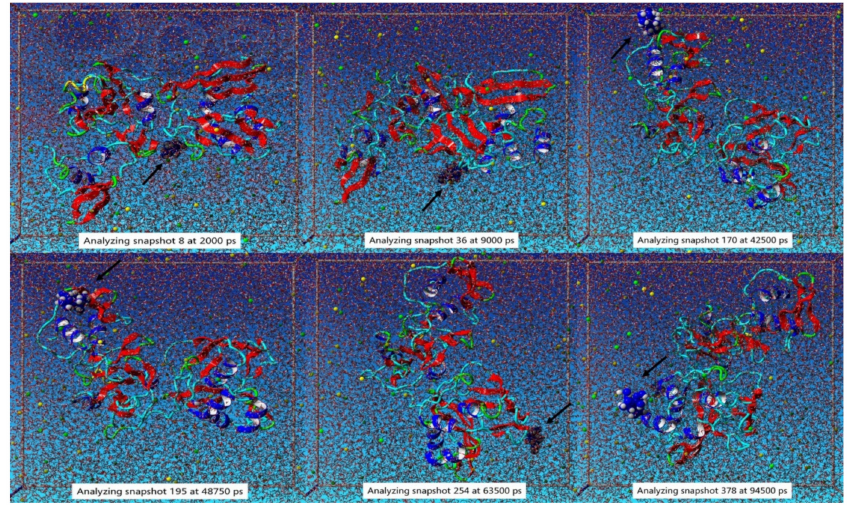
Figure 9. Snapshots of the molecular dynamic simulation process of the DTQ-NSP15